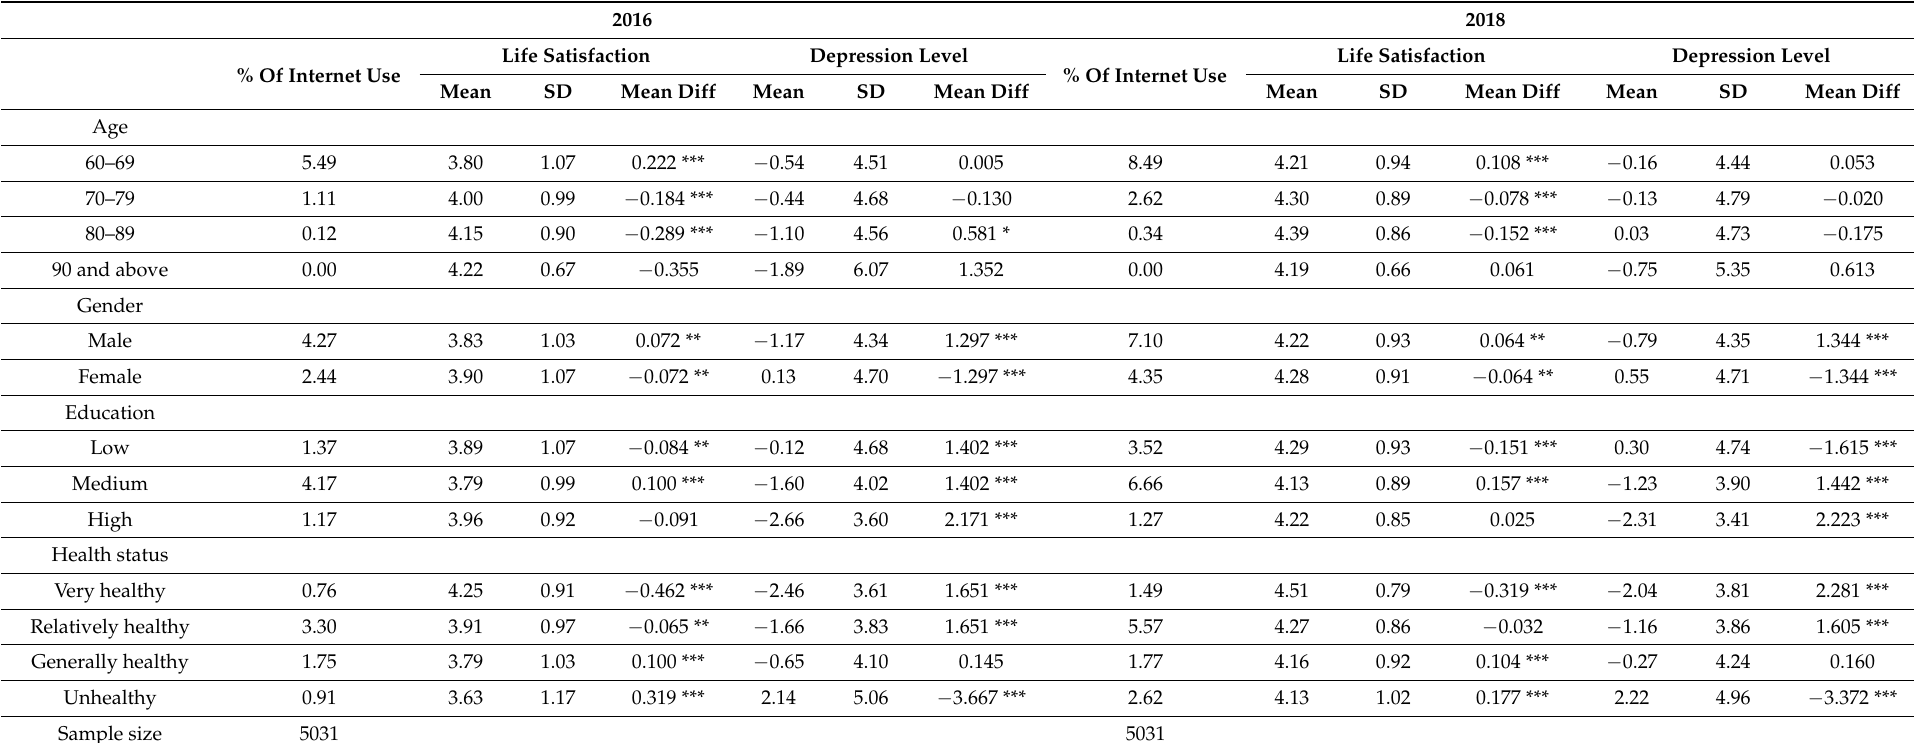
Table 2. Results of the descriptive analysis on